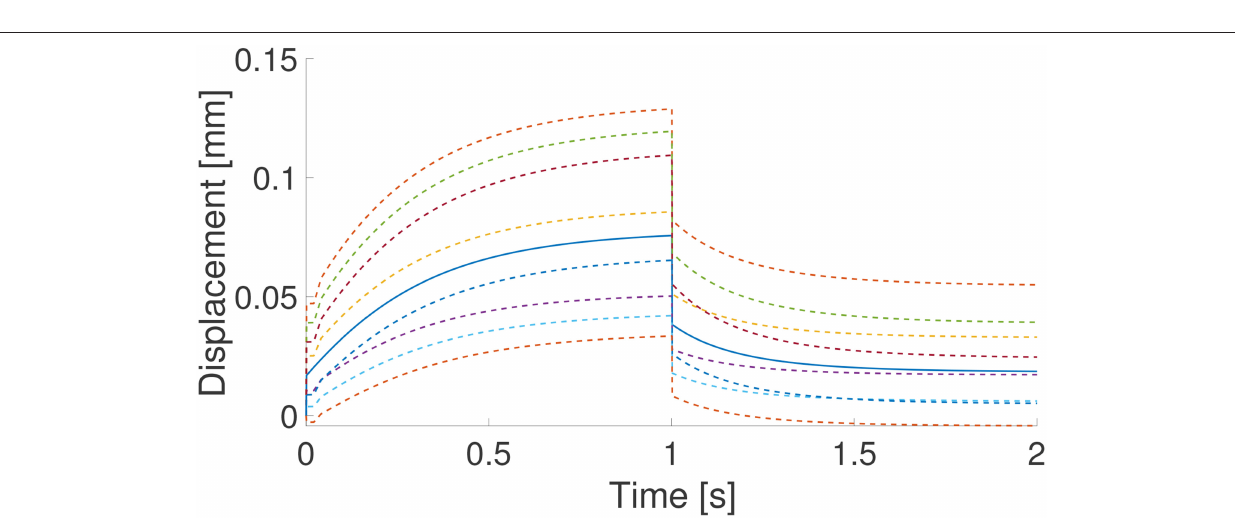
Frontiers in Materials |